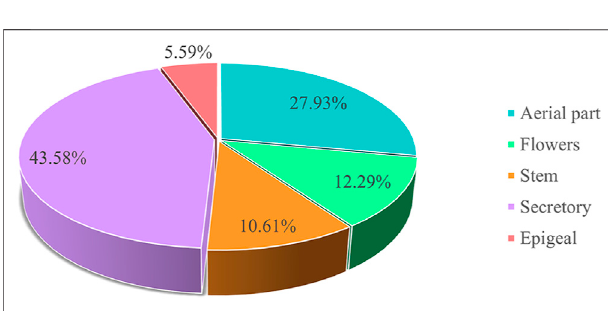
FIGURE 12 | Types and number of compounds isolated from the different part of A. sparsifolia